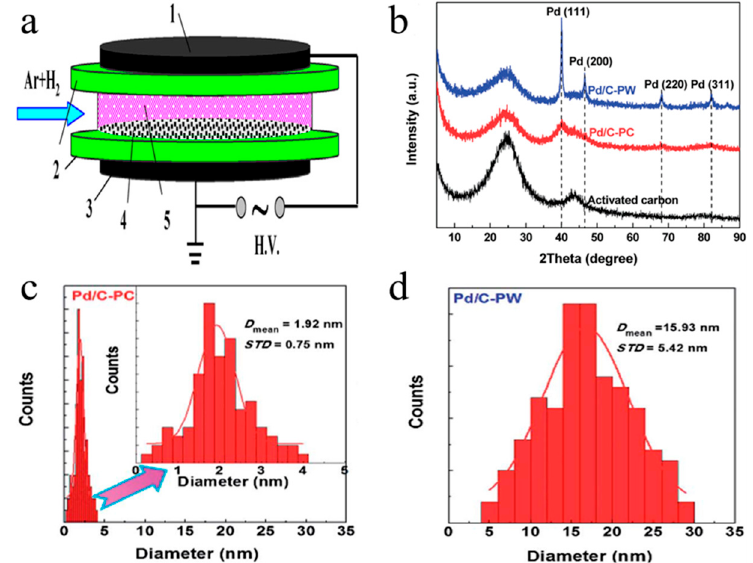
Figure 2. ( a ) the schematic of DBD cold plasma apparatus (1—high voltage electrode, 2—quartz glass, 3—low voltage electrode, 4—sample, and 5—cold plasma); ( b ) XRD patterns of the Pd/C-PW, Pd/C-PC and activated carbon; ( c ) the histograms of the particle size distributions of Pd nanoparticles corresponding to Pd/C-PC; ( d ) the histograms of the particle size distributions of Pd nanoparticles corresponding to Pd/C-PW. Reproduced with permission from [17,21]; Copyright Elsevier, 2013 and Royal Society of Chemistry, 2014.